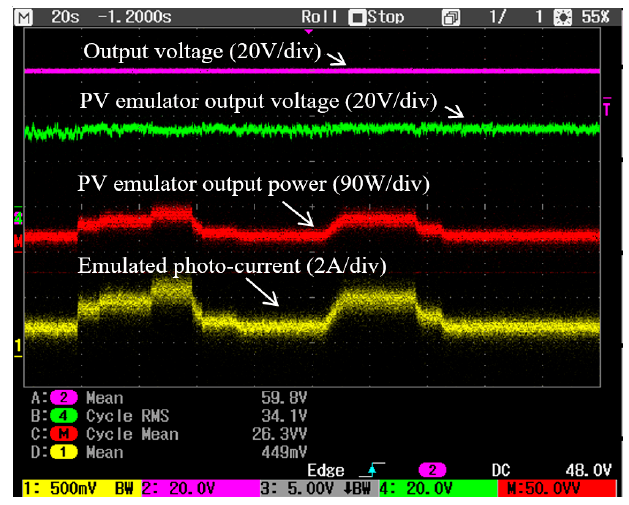
Figure 24. Test with varied external excitement current (in emulating different solar irradiance).